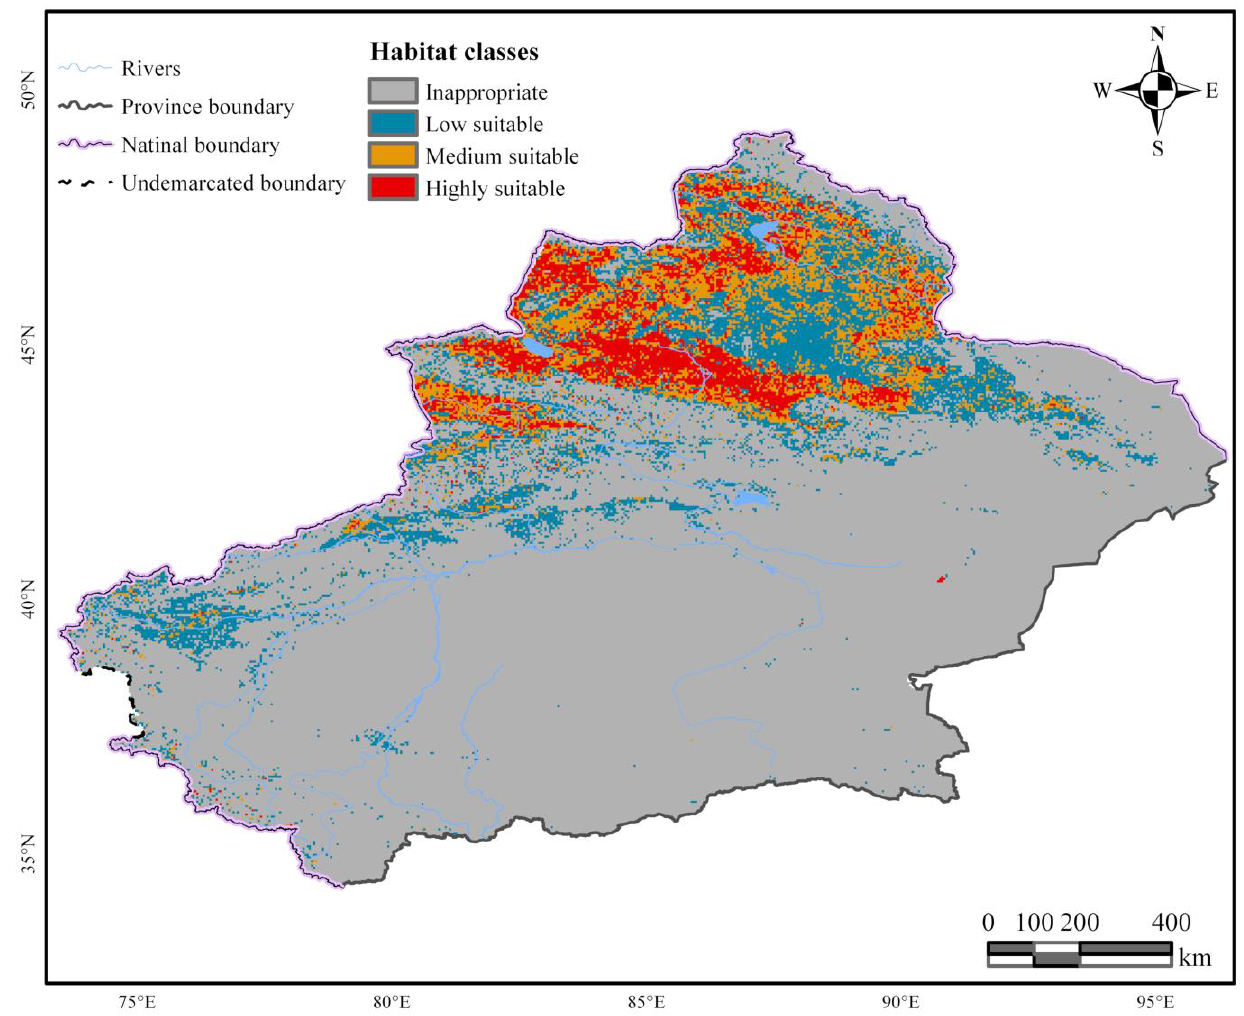
Figure 2. The habitat of AH (abiotic and host factors in C. deserticola distribution) in Xinjiang. And the suitable habitats are mainly in the north of region.